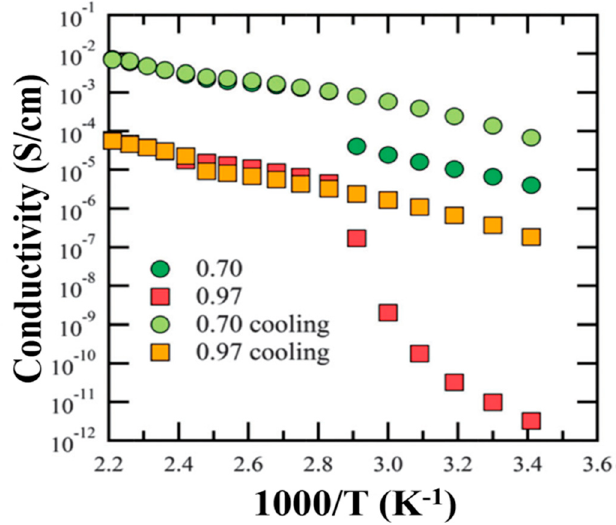
Figure 7. Comparison of ionic conductivities obtained for the Li x EMIM (1-x) TFSI (x = 0.70 and x = 0.97) system, data collected during heating and cooling, copyright; Reprinted with permission from Ref. [94]. Copyright 2014 The Royal Society of Chemistry.